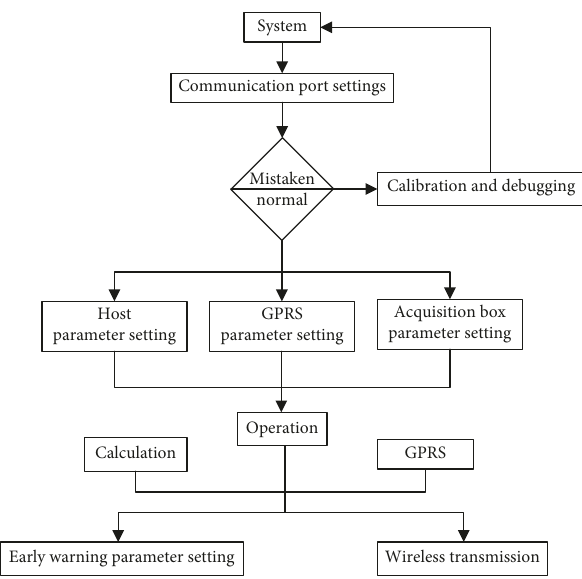
Figure 4: Schematic of the program